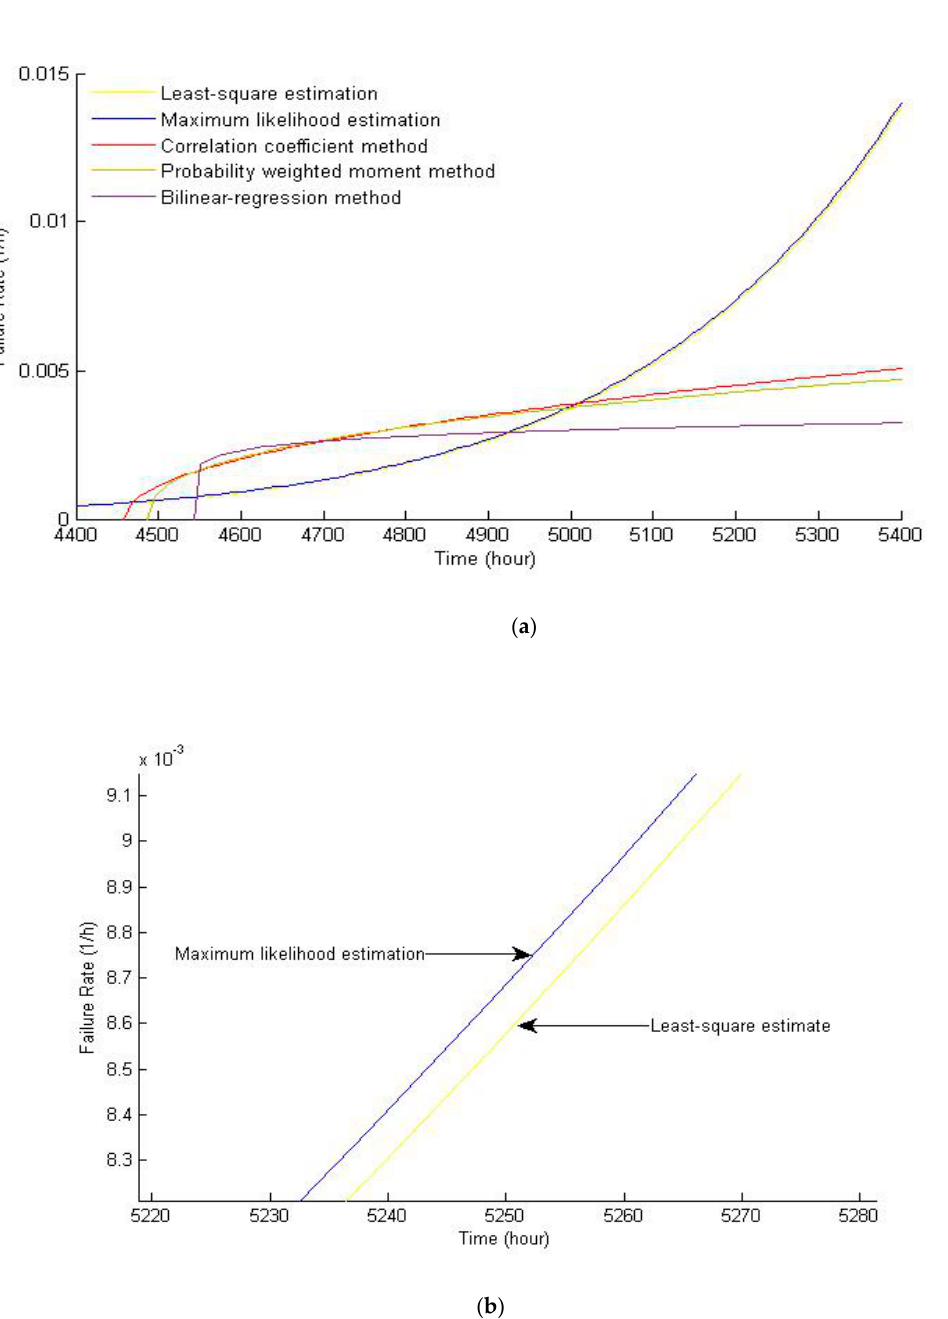
Table 3. Short period prediction on failure rates.